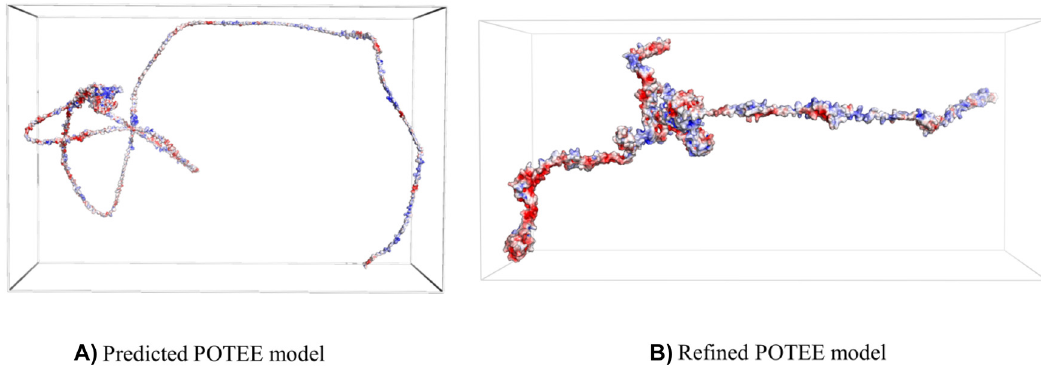
Figure 9: Electrostatics of POTEE represented in APBS maps.